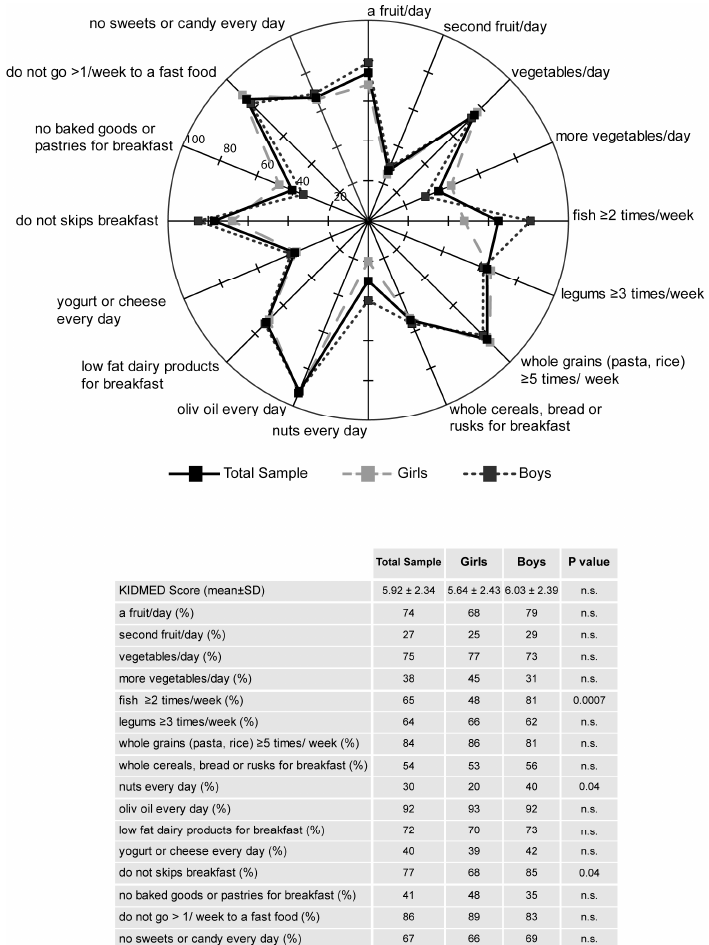
Figure 1. Compliance with items from the KIDMED test in the total sample, girls and boys. The radar chart plots the values of each item of Mediterranean diet score along a separate axis that starts in the center of the chart (0% compliance) and ends at the outer ring (100% compliance). The KIDMED score (M ± SD) and frequency (%) of the population adherent to each recommendation are reported in the table. Statistical differences were evaluated by Chi-squared tests. p < 0.05, girls vs. boys.